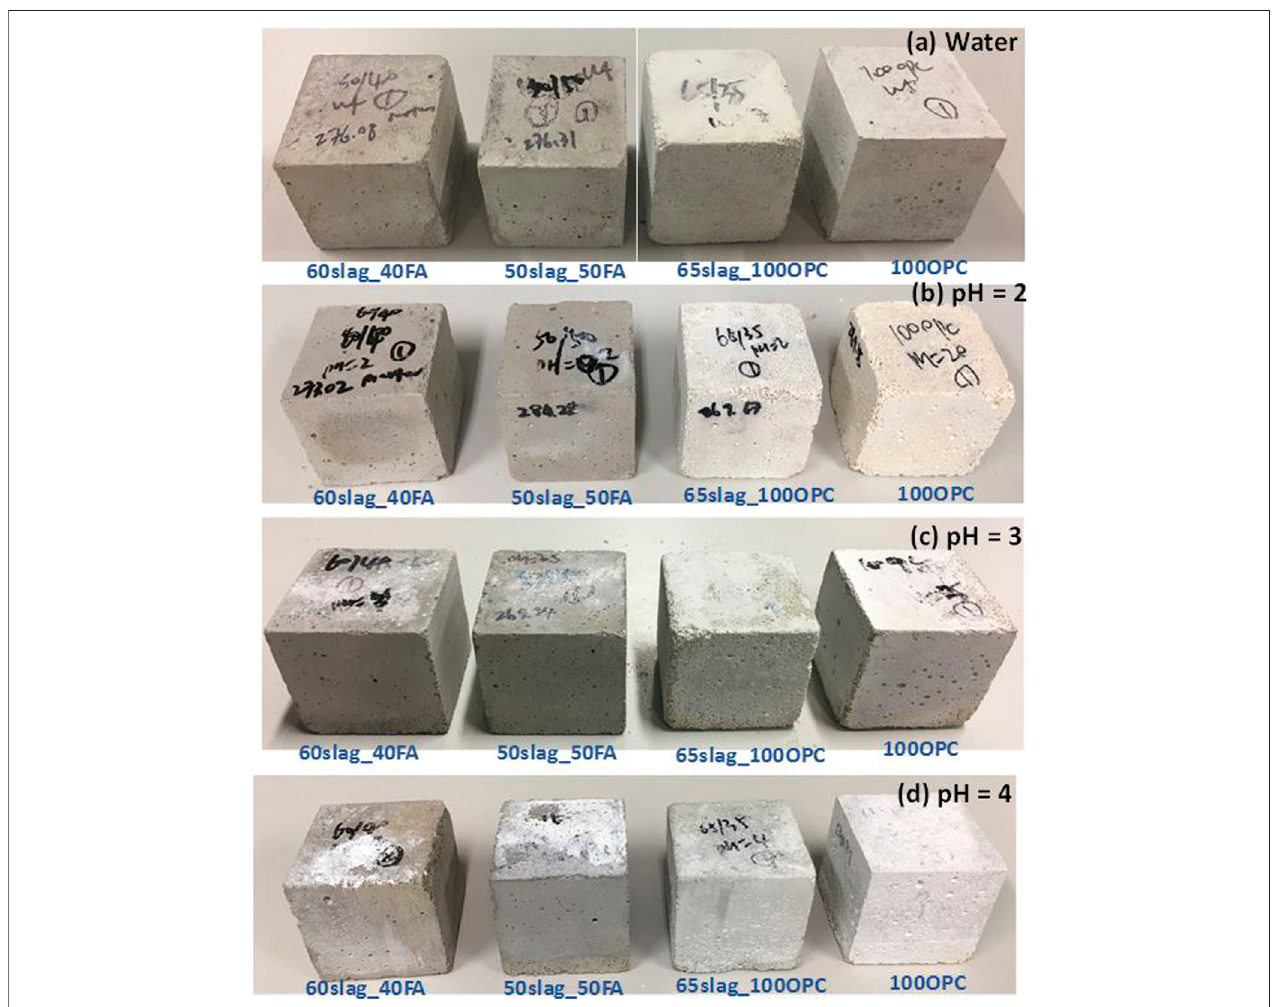
FIGURE3| Appearancesofmortarmixesafterimmersioninphosphoricacidfor150dayswithdifferentpHlevels: (A) pH=2.0, (B) pH=3.0, (C) pH=4.0and (D) in water with pH = 7.0.